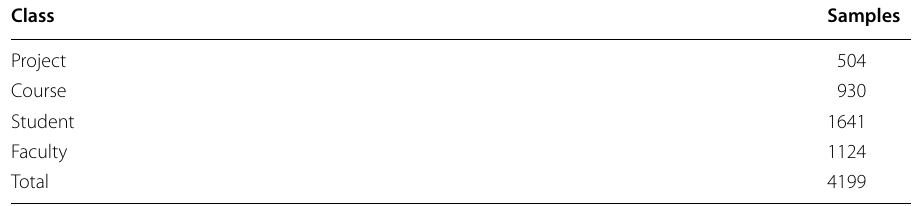
Table 3 Splitting of documents among four classes in Web‑KB dataset